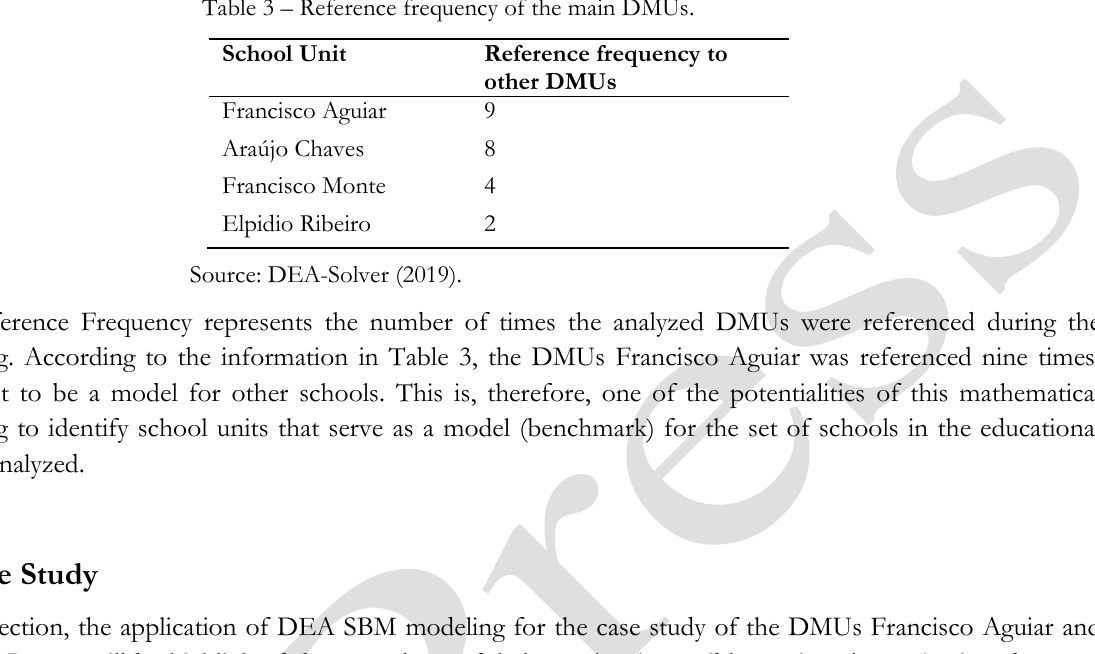
Table 4 - Projection of the Factors of two DMUs in Sobral.